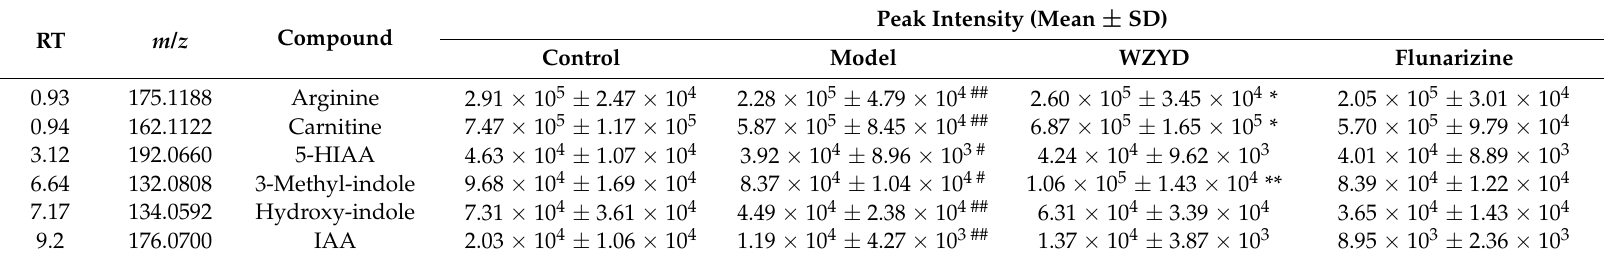
Table 2. Potential plasma biomarkers detected by LC-HRMS and their intensities in control, model, WZYD and flunarizine groups analyzed by one-way